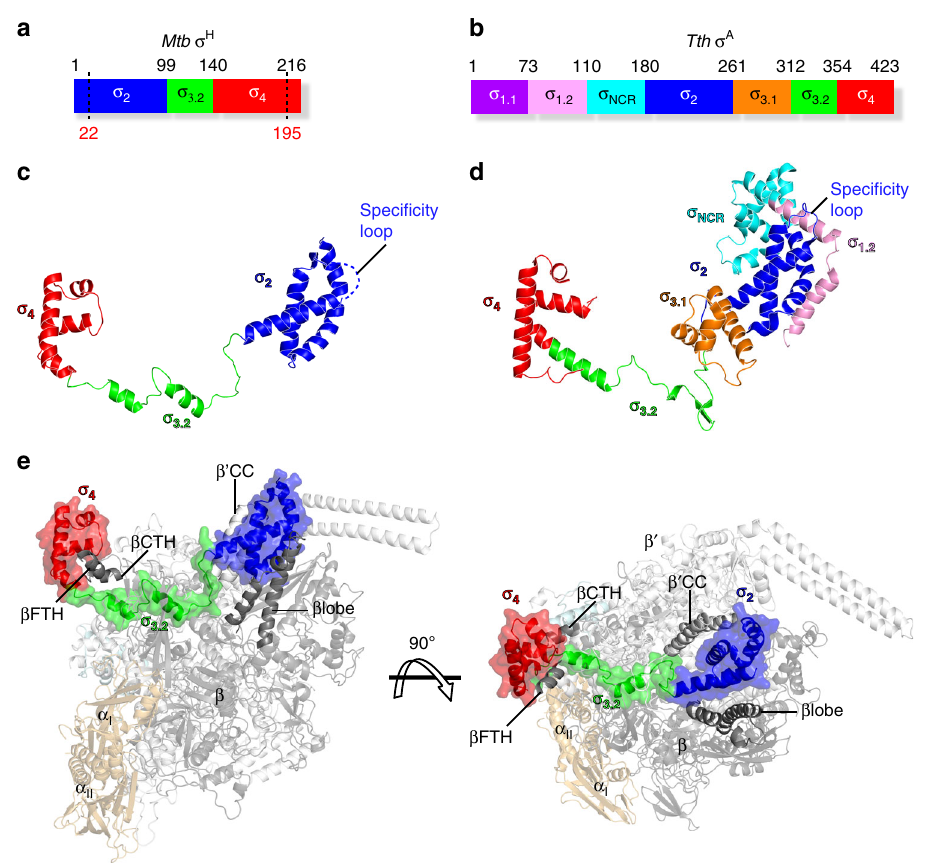
Fig. 1 The crystal structure of Mtb σ H -RNAP holoenzyme. a Schematic diagram of Mtb σ H . Ordered regions in the structure are indicated by dashes. b Schematic diagram of T. thermophilus σ A . c σ H in the crystal structure of Mtb σ H -RNAP holoenzyme. The disordered speci fi city loop is shown by blue dashes. d σ A in the crystal structure of T. thermophilus σ A -RNAP (PDB: 1IW7) [https://www.rcsb.org/structure/1iw7] was used for comparison due to no available structure of Mtb σ A -RNAP holoenzyme. e Front and top views of Mtb σ H -RNAP holoenzyme. β FTH, the fl ap-tip helix on RNAP- β subunit; β CTH, the C-terminal helix on RNAP- β subunit; β ′ CC, the coiled-coil on RNAP- β ′ subunit. σ A 1.1 , purple; σ A 1.2 , pink; σ A NCR , cyan; σ 2, blue; σ A 3.1 , orange; σ 3.2 , green; σ α subunits, light orange; RNAP- β subunit, black; RNAP- β ′ subunit, gray; RNAP- ω subunit, light 4 , red. RNAP-